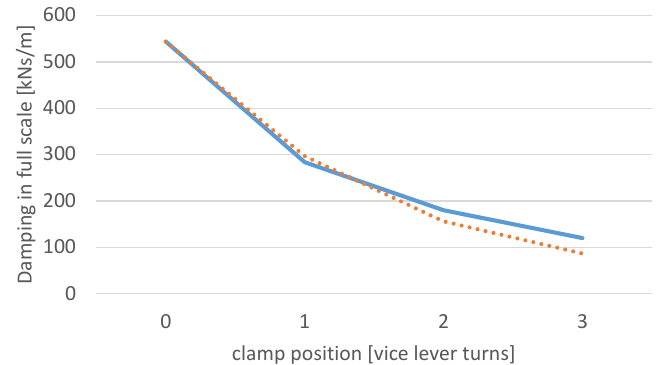
Figure 5. Measured damping of the PTO (blue) in relation to the gap width, measured in turns of the vice knob. The dotted line shows the trend of the magnetic flux according to Equation (1). The curve is scaled so that it matches with the measurement for the zero clamp position.